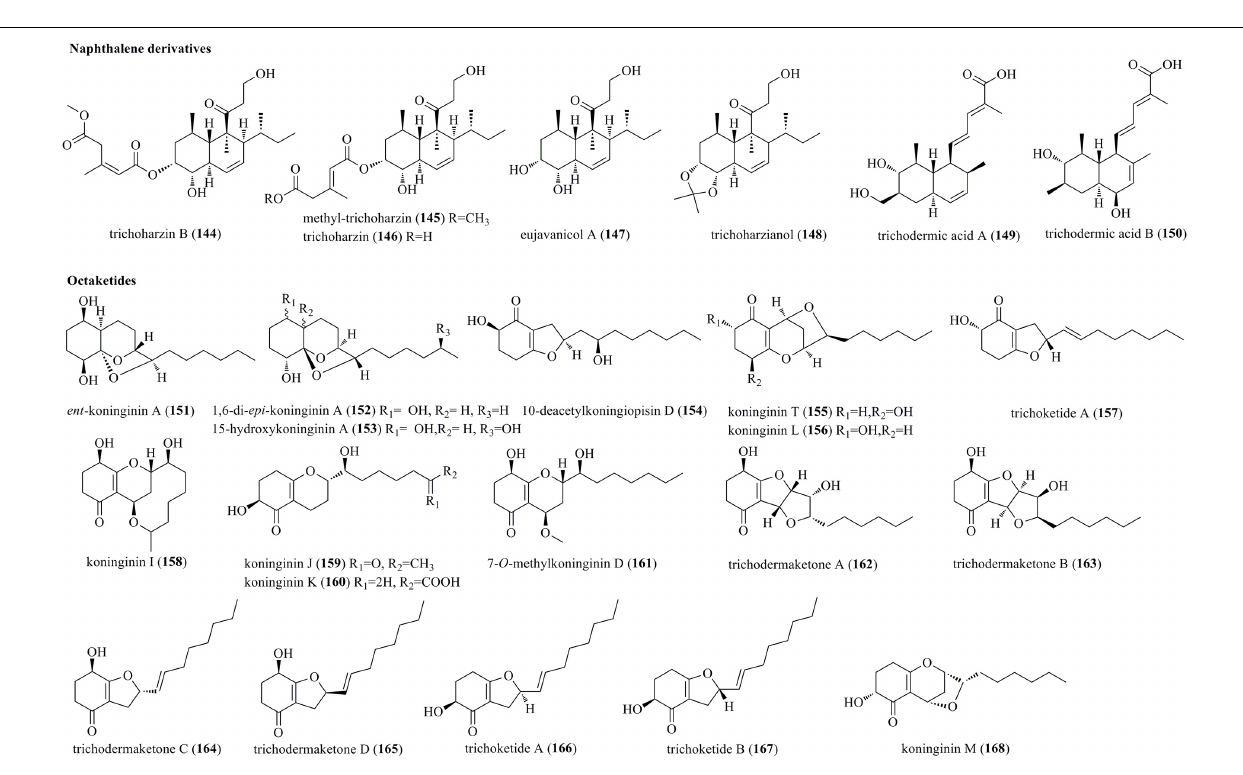
FIGURE 8 | Naphthalene and octaketide derivatives produced by Trichoderma species ( 144–168